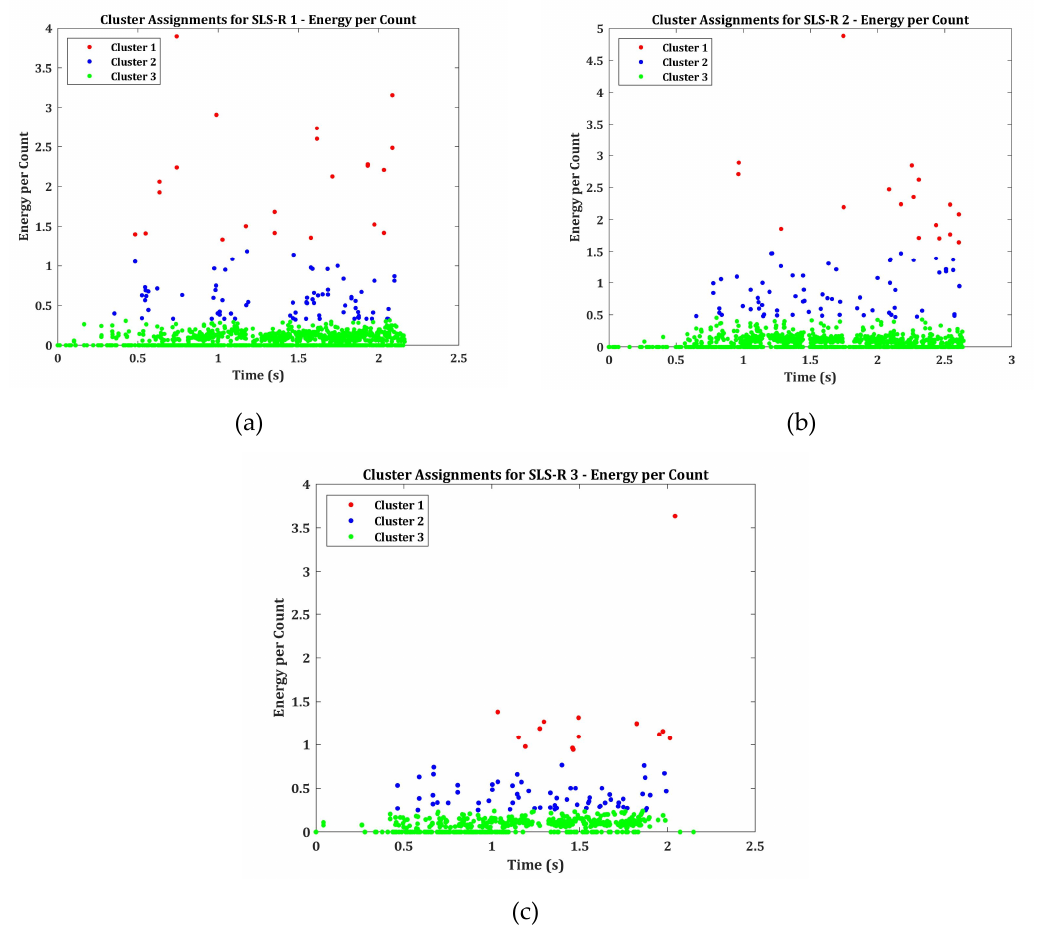
Figure 10. Clustered Energy per count for Specimens ( a ) SLS-R 1 ( b ) SLS-R 2 and ( c ) SLS-R 3.